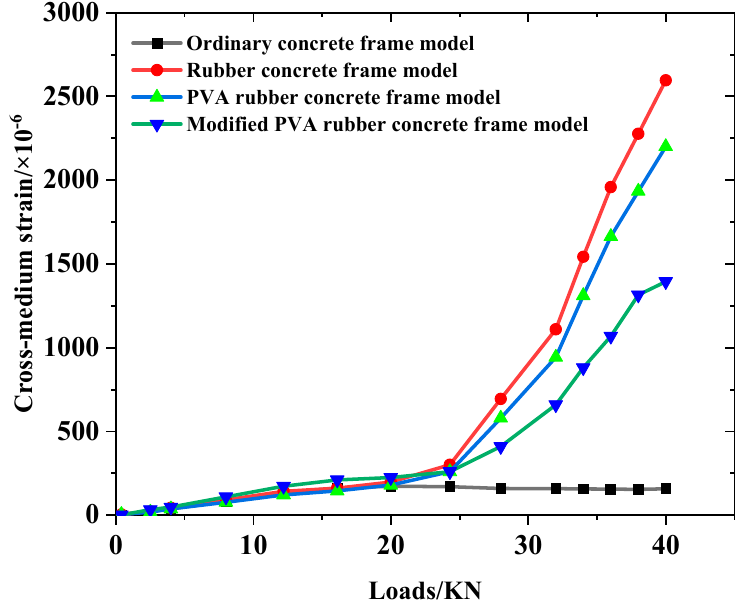
Figure 15. Relationship curves between strain and load in four frame structures.